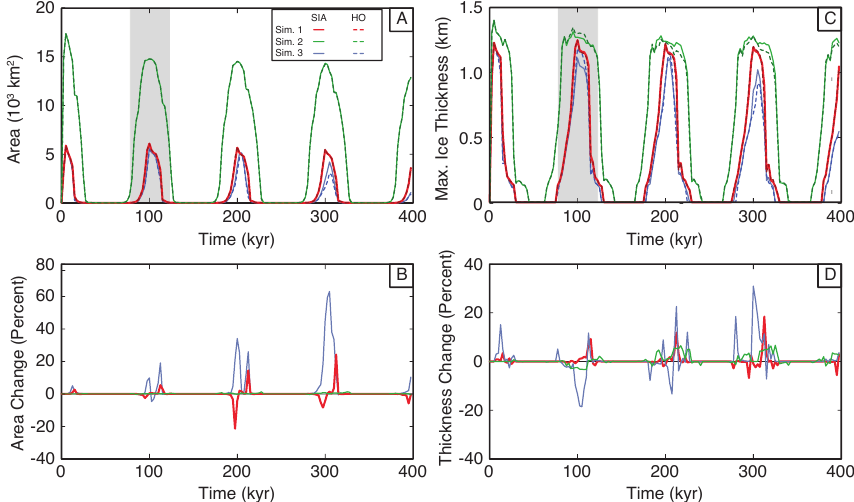
Figure 4. Variations in glaciated area and maximum thickness over 400kyr. The colors correspond to the simulations in Table 2 and described in Sect. 2.2. For (a) and (c) , solid lines indicate the SIA model, and dashed lines the HO. (a) The area is defined at each time step by the area covered by ice greater than 10m thick. Solid lines indicate the SIA model, and dashed lines the HO. (b) The percent difference between the SIA and HO. (c) The maximum ice thickness is defined at each time step when ice greater than 10m thick exists. (d) The percent difference between the SIA and